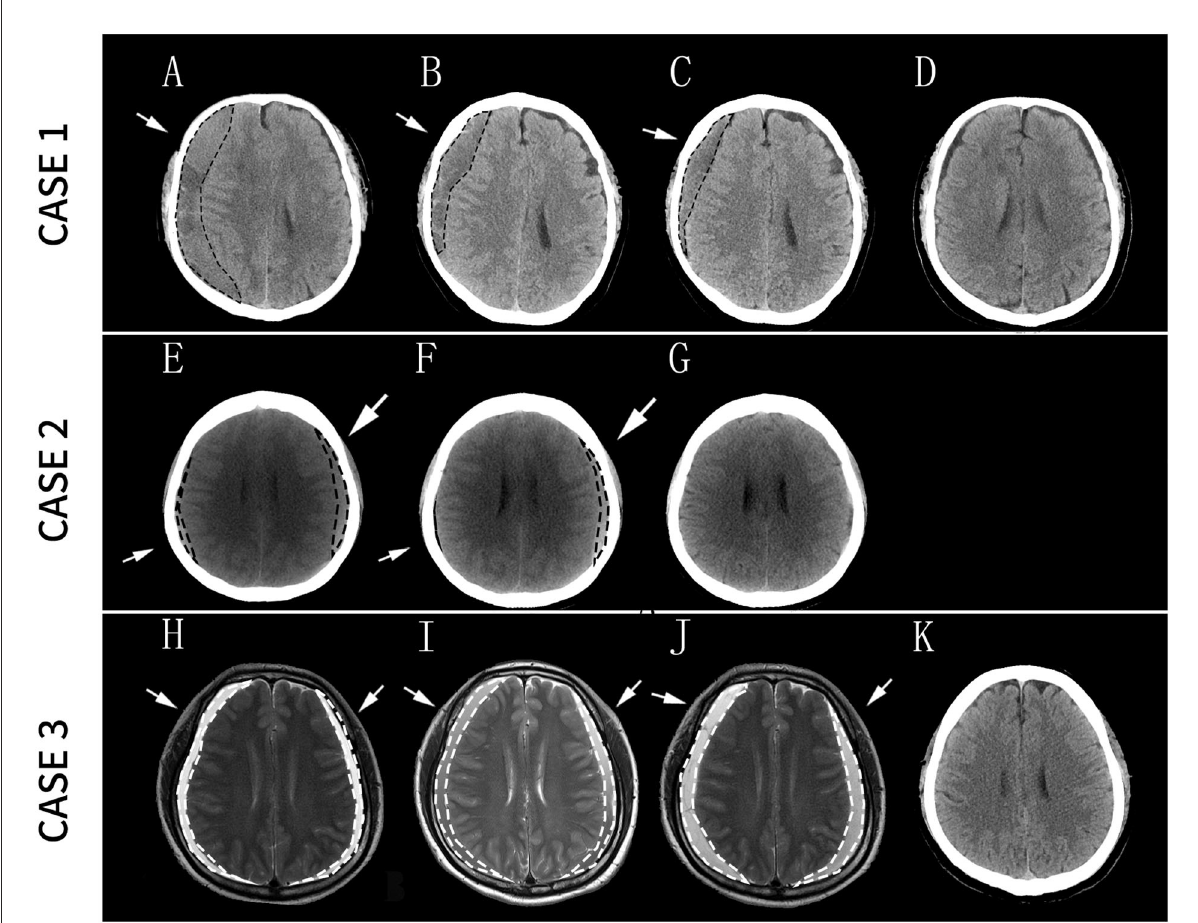
FIGURE2 Case 1: (A) Diagnosis of right SDH; (B) The size of SDH significantly decreased after 9 days of the treatment; (C) SDH continued to decrease in size after 1 month of treatment; (D) the residual hematomas resolved 3 months after the treatment. Case 2: (E) Diagnosis of bilateral SDH; (F) the size of the right SDH significantly decreased after 1 month of the treatment; (G) the residual hematomas resolved 4 months after the treatment. Case 3: (H) Diagnosis of bilateral SDH; (I) Headache considerably decreased after 15 days of treatment but without a reduction in the size of the hematoma on MRI images; (J) Seventeen days later, a head MRI revealed an expansion of the SDH, and the patient underwent surgery after 2 days; (K) Two months later, the patient recovered well without any neurological sequelae. Arrows and dashed lines indicate the locations of SDH. SDH, subdural hematoma; MRI, magnetic resonance